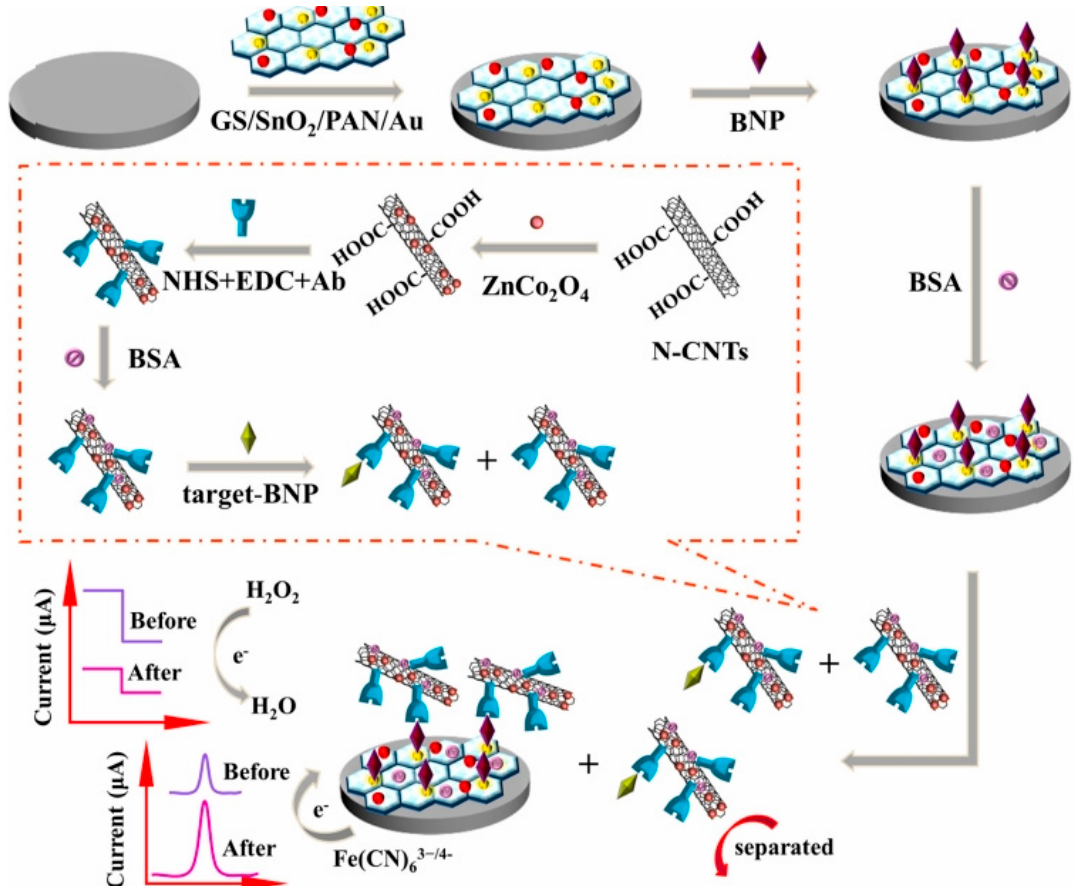
Figure 3. The schematic illustration of the dual mode competitive electrochemical immunosensor. Reprinted with Permission [38].